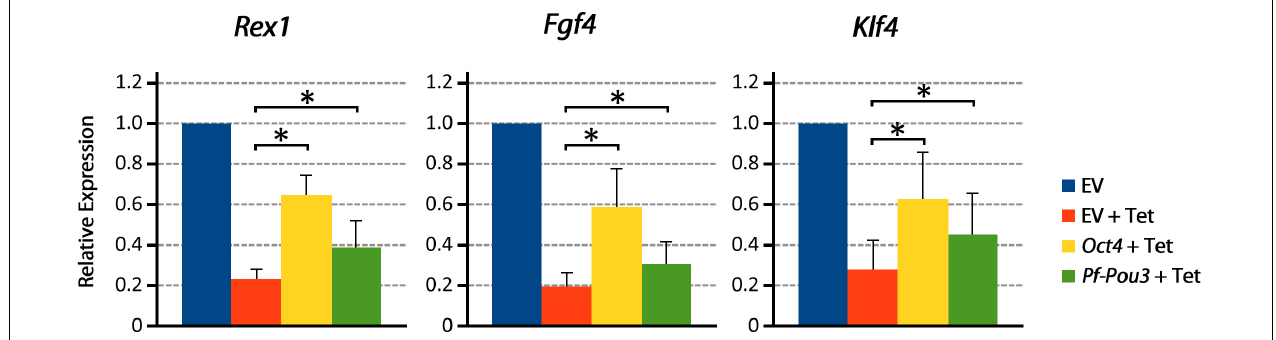
FIGURE 6 | Pf-Pou3 maintains expression of stem cell genes on loss of Oct4 in mouse embryonic stem cells. ZHBTc4 cells were stably transfected with vectors constitutively expressing mouse Oct4 , P. flava Pou3 (Pf-Pou3) , or empty vector negative control (EV). Stable cell lines were then grown for 24 h in the presence or absence of tetracycline (Tet). The graph shows the results of qPCR on cDNA generated from these cells measuring Oct 4- associated stem cell genes Rex1 ( Zfp42 ), Fgf4 , and Klf4 , displayed as quantities relative to negative control (EV). Asterisks represents statistical significance determined with the Mann–Whitney U test ( p < 0.05). Expression of target genes was significantly reduced in the absence of Oct4 and Pf-Pou3 , but expression of all Oct4 -associated genes tested was significantly recovered by stable transfection of mouse Oct4 or hemichordate Pf-Pou3